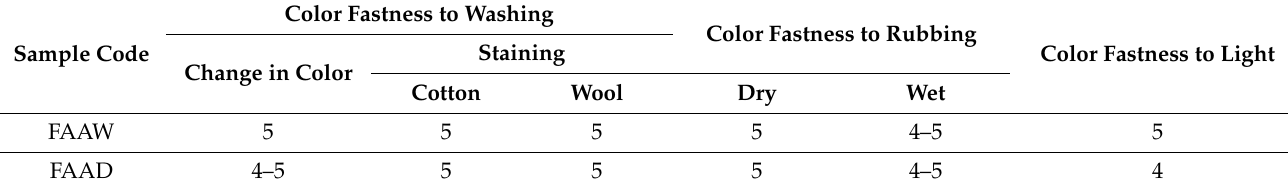
Table 4. Results of color-fastness tests for samples functionalized in an acidic environment (pH = 2).